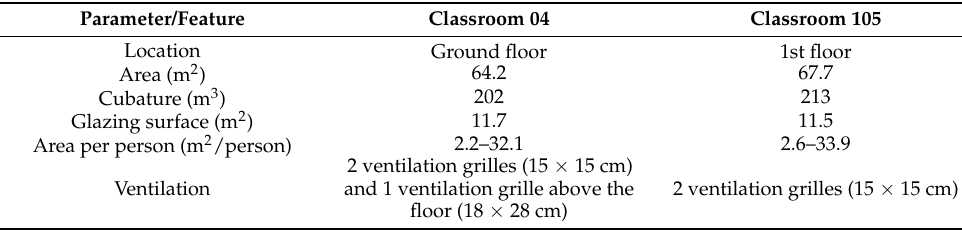
Table 1. Characteristics of the studied